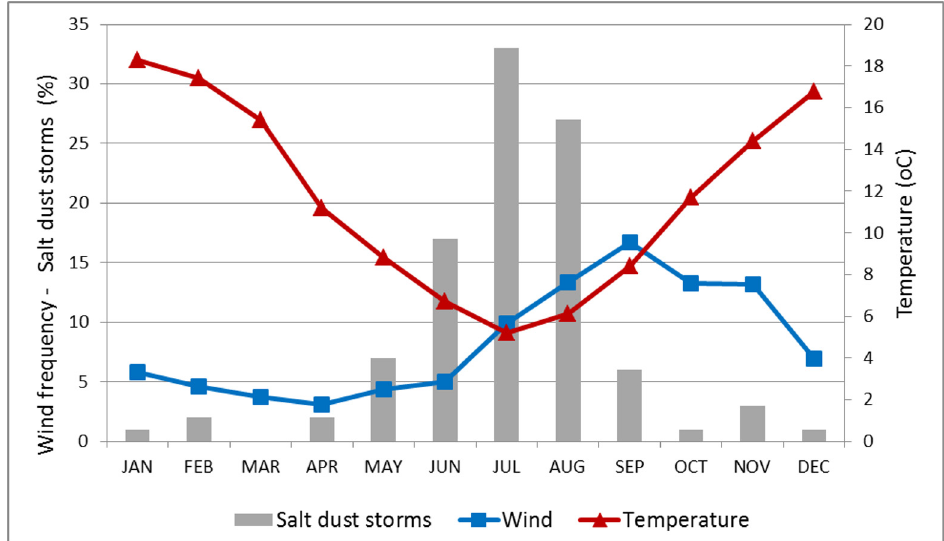
Fig 7. Mar Chiquita: monthly frequency of salt dust storms (%), days with wind over 27 km/h (%), and mean monthly minimal temperature (C). Temperature records from Miramar, 30° 57 ’ S; 56° 20 ’ W. Servicio Meteorológico Nacional,